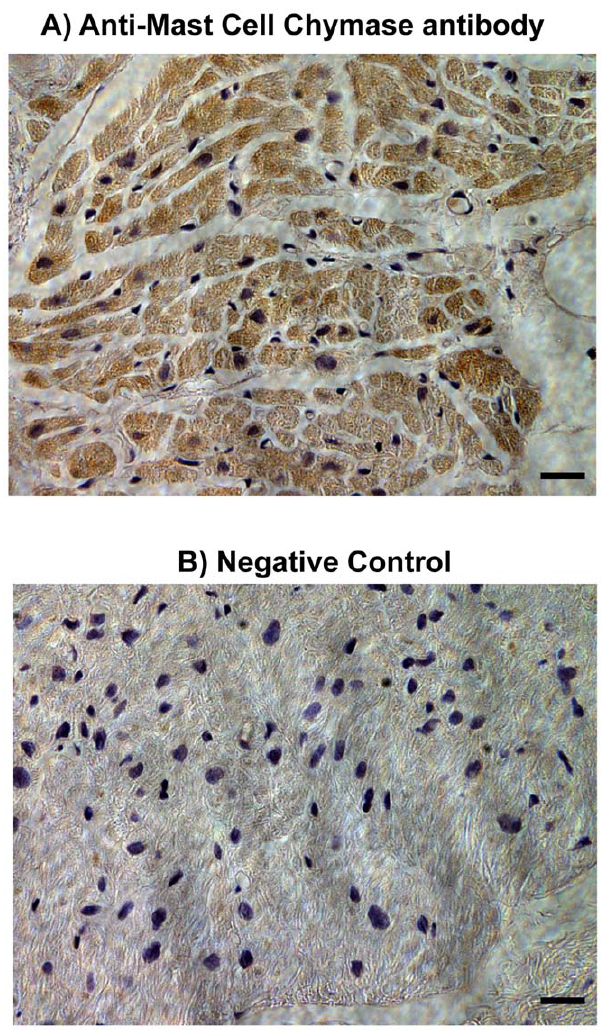
Figure 5. Immunohistochemistry of human atrial tissue for chymase. Immunostaining of human atrial tissue using an Anti-Mast Cell chymase antibody (Abcam Inc., Cambridge, MA; Cat # ab2377) revealed high expression of chymase within atrial cardiac myocytes (A). Negative control without primary antibody shows no staining for chymase (B). (Magnification 400; scale bar is 50 m m) .